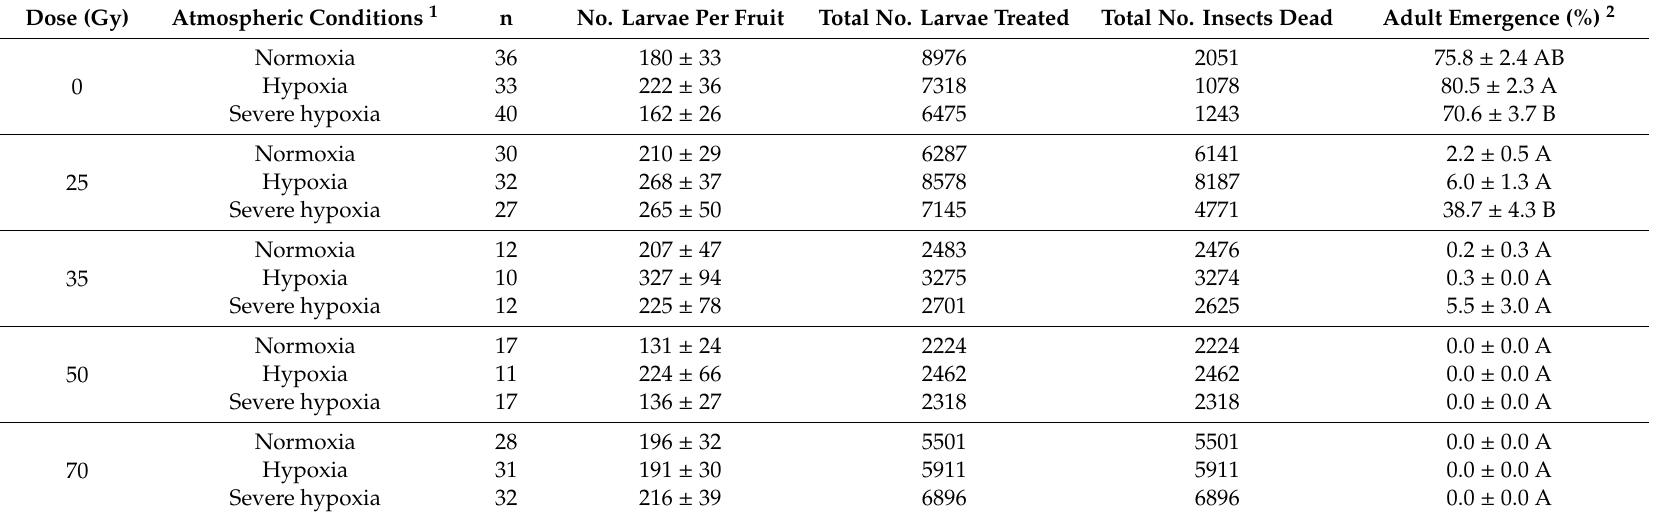
Table 1. Numbers of replicates, larvae per fruit (mean ± SE), treated larvae, dead insects, and adult survival (mean ± SE) of Anastrepha fraterculus third instars irradiated at di ff erent nominal doses and atmospheric